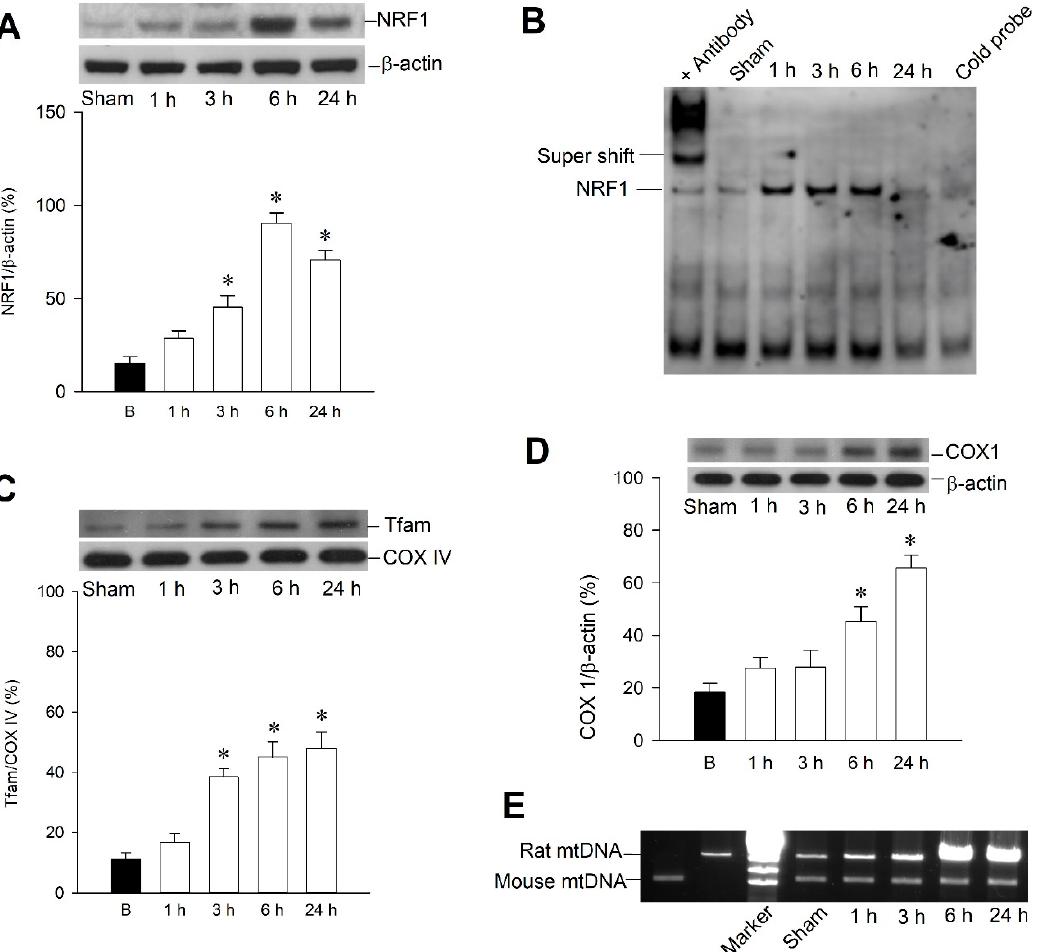
Figure 2. Involvement of mitochondrial biogenesis in kainic acid (KA)-induced status epilepticus in hippocampal CA3 subfield. ( A ) Temporal changes in nuclear respiratory factor 1 (NRF1) protein relative to β -actin protein. ( B ) Representative gel depicting electrophoresis mobility shift assay of NRF1 DNA binding activity in nuclear extracts from right CA3 subfield of hippocampus 1–24 h after microinjection of KA (0.5 nmol) into left hippocampal CA3 subfield. ( C ) Mitochondrial fraction of samples collected 1–24 h after microinjection of KA (0.5 nmol) or PBS into left hippocampal CA3 subfield for mitochondrial transcription factor A (Tfam) expression. Cytochrome c oxidase IV (COX IV) was used as internal loading control for mitochondrial fraction. ( D ) Temporal changes in COX I protein relative to β -actin protein. ( E ) Long PCR for quantitation of mitochondrial DNA revealed temporal change after microinjection of KA (0.5 nmol) or PBS into left hippocampal CA3 subfield. Values are mean ± SEM of the ratio of β -actin or COX IV to loading controls and are quadruplicate analyses from six animals per experimental group in ( A , C and D ). * p < 0.05 versus sham-control group in the Scheffé multiple-range test.